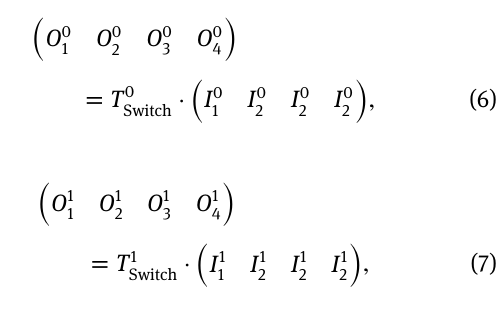
to O , respectively. The light 1 4